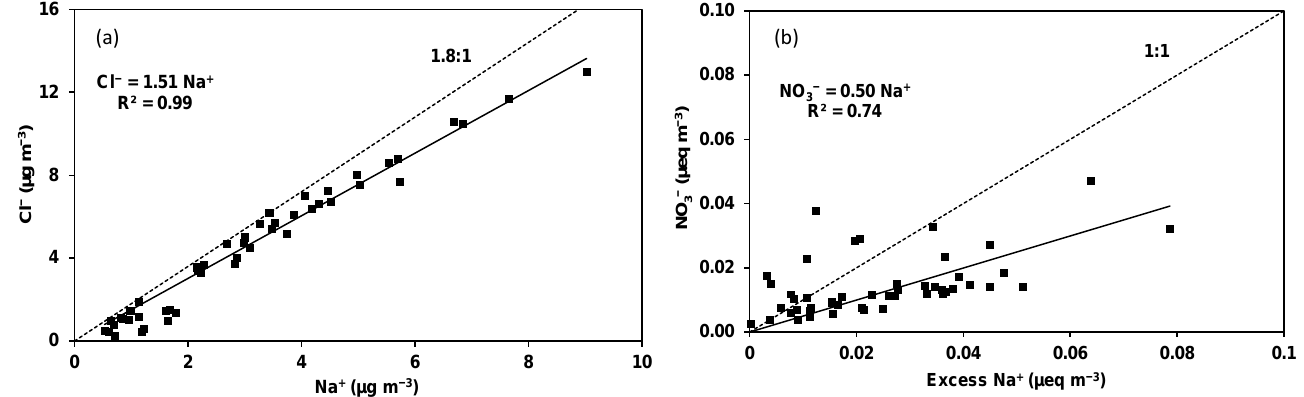
Figure 7. Correlations between: ( a ) Cl − and Na + , ( b ) NO 3 − and excess Na + . Dashed line in ( a ) indicates the typical fresh sea-salt-particles’ Cl − /Na + mass ratio of 1.8. Dashed line in ( b ) is the 1:1 line.